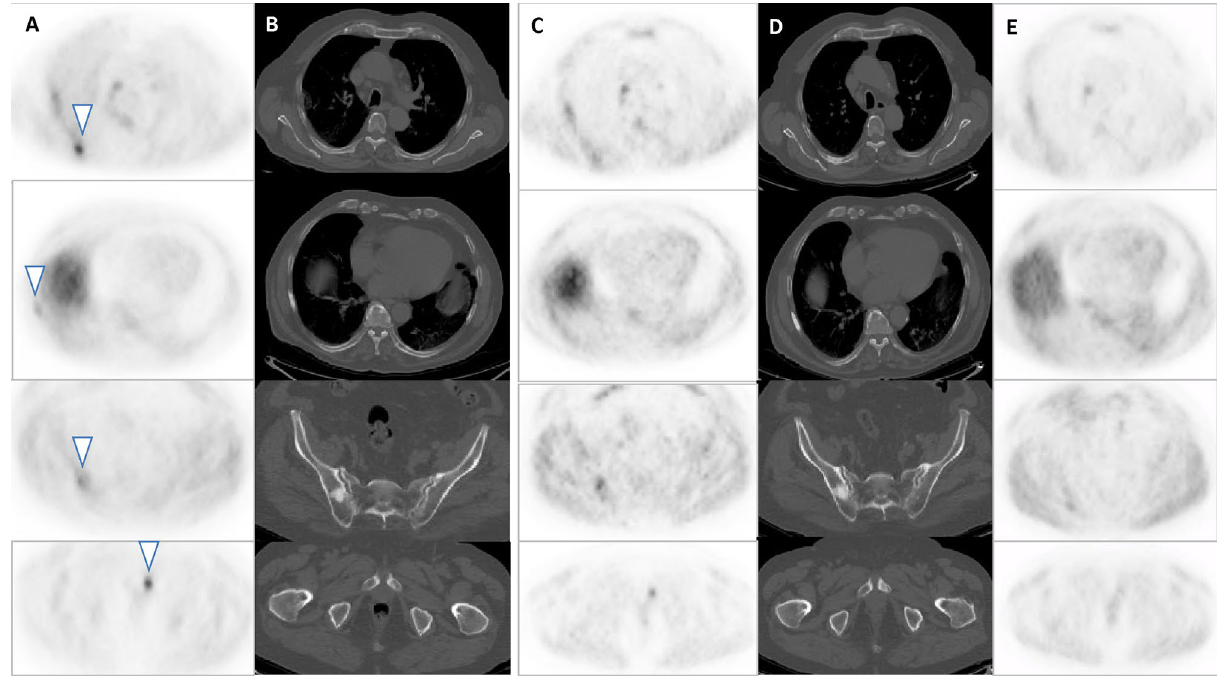
Figure 4. Patient ≠ 2. Axial slices of baseline FCH PET/CT ( A , B ) showing four lesions with uptake and blastic reaction (arrow-heads). Axial slices of interim FCH PET/CT ( C , D ) show stability in lesion number, with reduction of metabolism. Axial slices of end-treatment FCH PET portion ( E ) show a reduction of uptake with minimal visual detection of lesions.